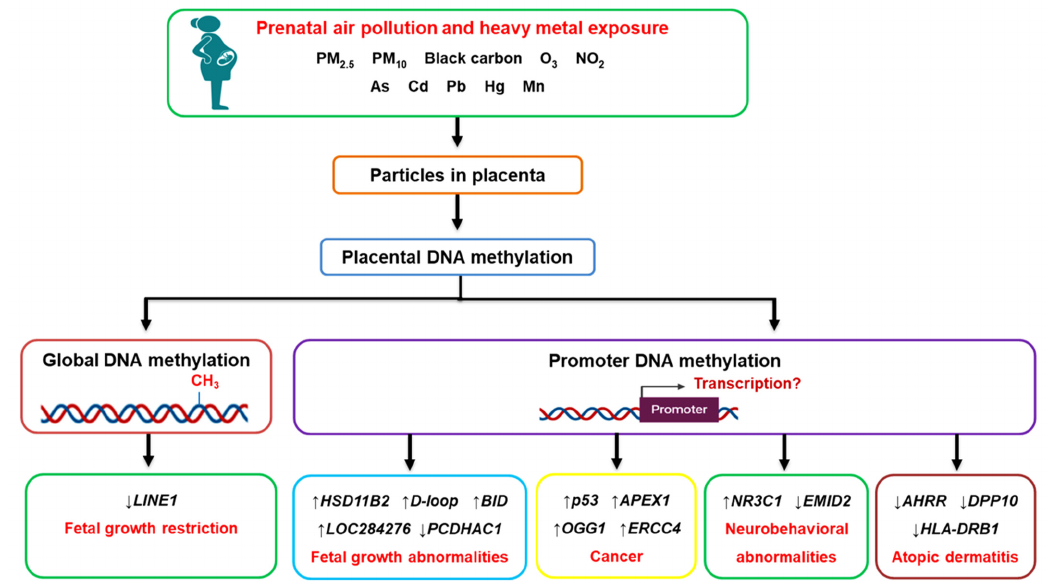
Figure 3. The effects of prenatal air pollution exposure on placental DNA methylation patterns and its implications on fetal development and future disease susceptibility. Maternal exposure to air pollution, including heavy metals, can reach the placenta, where they alter DNA methylation patterns at both the global and gene promoter level. The aberrant methylation of genes affects fetal growth ( HSD11B2 , BID , D-loop , PCDHAC1 , LOC284276 ) and increases the risk of developing cancer ( p53 , APEX1 , OGG1 , ERCC4 ), neurobehavioral abnormalities ( NR3C1 , EMID2 ), and atopic dermatitis ( AHRR , DPP10 , HLA-DRB1 ) in later life. Abbreviations: AHRR: aryl hydrocarbon receptor repressor; APEX1: AP endonuclease 1; As: arsenic; BID: BH3 interacting domain death agonist; Cd: cadmium; D-loop: displacement loop control region (heavy strand); DPP10: dipeptidyl peptidase 10; EMID2: EMI domain-containing protein 2; ERCC4: excision repair 4; Hg: mercury; HLA-DRB1: HLA class II histocompatibility antigen, DRB1 beta chain; HSD11B2: 11 β -hydroxysteroid dehydrogenase 2; LINE1: long interspersed nuclear element 1; Mn: manganese; NO 2 : nitrogen dioxide; NR3C1: nuclear receptor subfamily 3 group C member 1 glucocorticoid receptor; O 3 : ozone; OGG1: oxoguanine glycosylase 1; p53: tumor suppressor protein 53; Pb: lead; PCDHAC1: protocadherin alpha subfamily C1; PM 2.5 : particulate matter with an aerodynamic diameter smaller than 2.5 µ m; PM 10 : particulate matter with an aerodynamic diameter smaller than 10